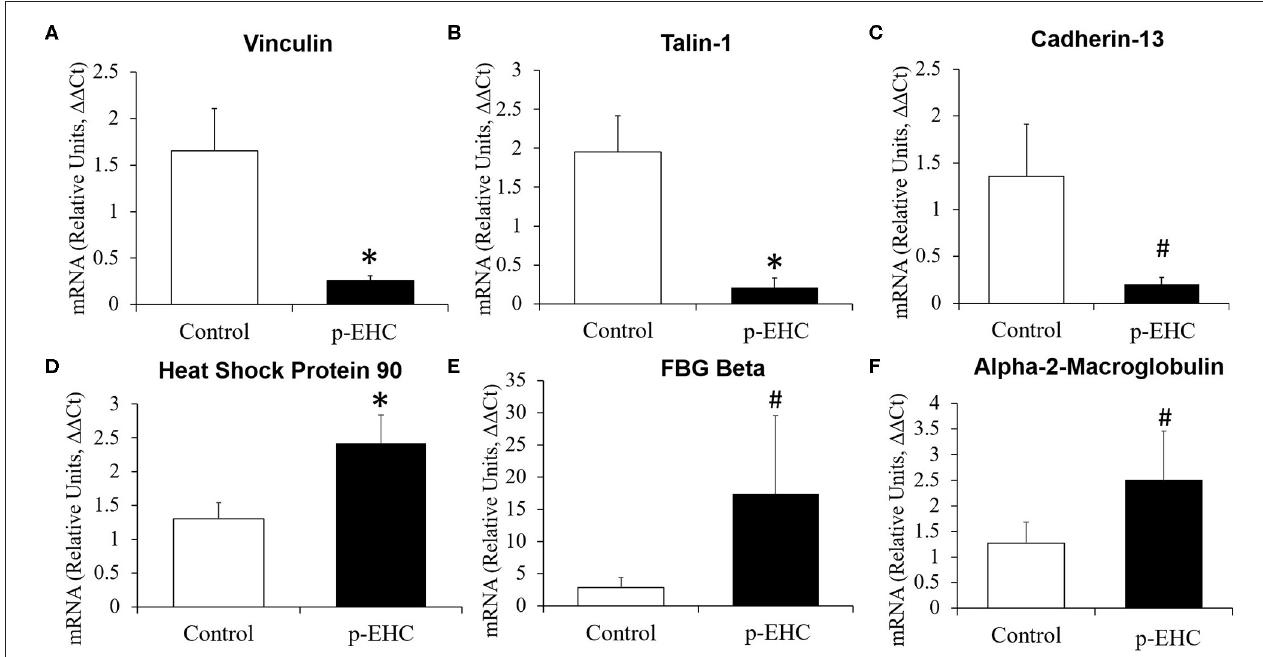
FIGURE 6 | Mean fold change in messenger RNA (mRNA) expression of significantly differentially expressed proteins in lamellar tissue from healthy and hyperinsulinemic horses. mRNA expression of (A) vinculin, (B) talin-1, and (C) cadherin-13 were decreased in hyperinsulinemic (p-EHC) horses, while mRNA expression of (D) heat shock protein 90, (E) fibrinogen beta, and (F) alpha-2-macroglobulin were increased in hyperinsulinemic horses compared to controls. n = 4/group; * p < 0.05 vs. control, # p < 0.1 vs. control; statistical test: 11 Ct method and two-tailed t -test.